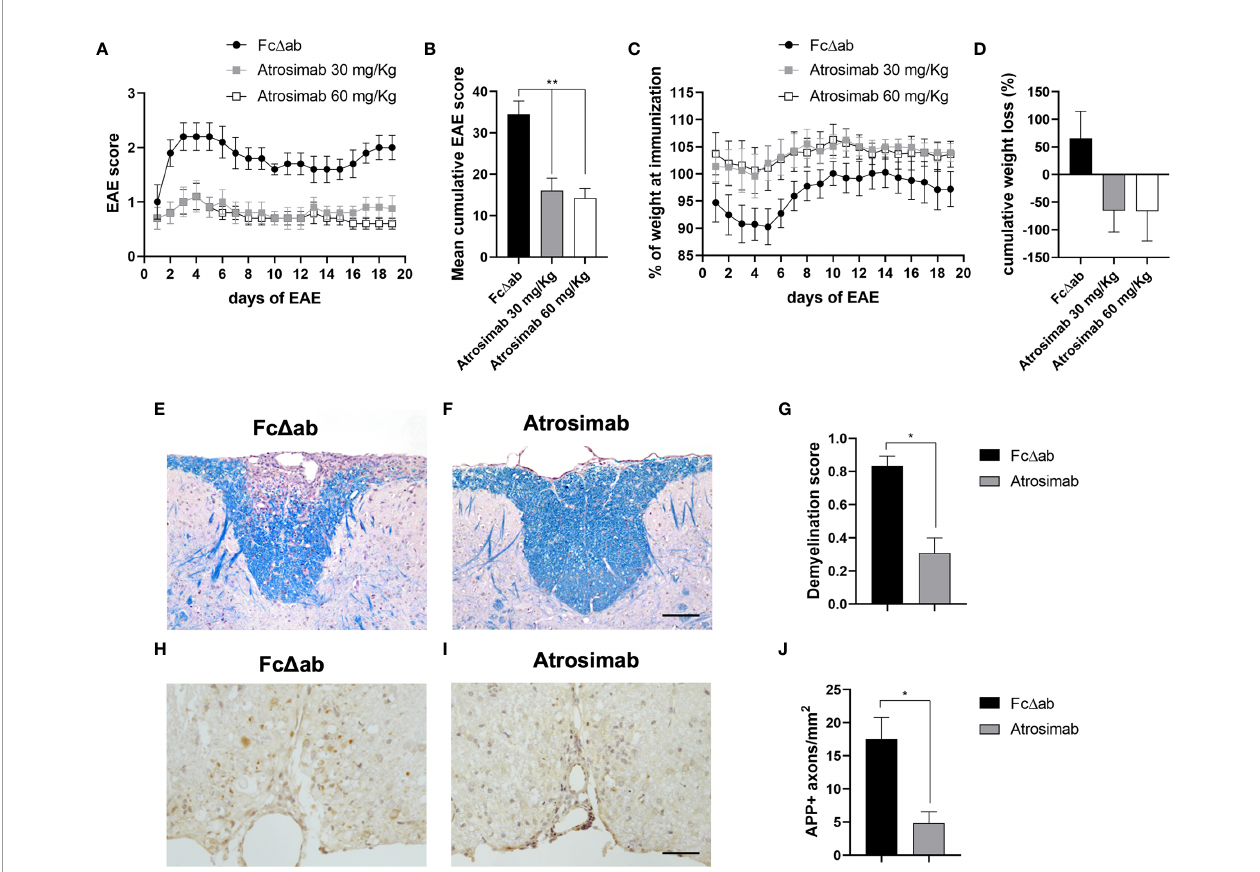
FIGURE 7 | Atrosimab ameliorates disease in a model of multiple sclerosis. huTNFR1-k/i mice were immunized with MOG 35-55 peptide to induce EAE. Mice were injected i.p. on days 1, 4, 8 and 12 of manifest disease with either 30 mg/kg or 60 mg/kg Atrosimab, or 30 mg/kg Fc D ab. Both dosages of Atrosimab led to an immediate and sustained improvement in (A) motor symptoms, re fl ected by the (B) cumulative EAE score, as well as a reduction in (C) disease-associated weight loss, also supported by (D) the cumulative weight loss. Two of the major pathological hallmarks of EAE, demyelination and axonal degeneration were investigated histopathologically. (E – G) Luxol fast blue (LFB) staining revealed, in comparison to Fc D ab treated animals, signi fi cantly reduced demyelination following treatment with 30 mg/kg Atrosimab. (H – J) Treatment with 30 mg/kg Atrosimab also lead to a reduction in the number of damaged axons indicated by APP accumulation. Representative images are shown from Fc control (E, H) and Atrosimab-treated (F, I) mice. e,f,h,i: scale bars = 50 µm. a-d: Mean ± SEM, n=6; g,j: n=6 per group: *p<0.05,